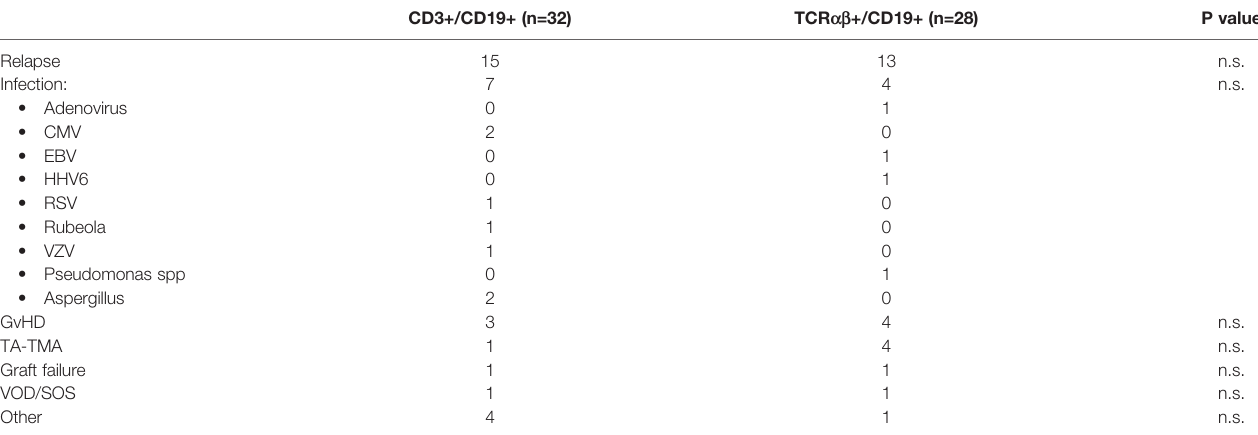
TABLE 2 | Causes of